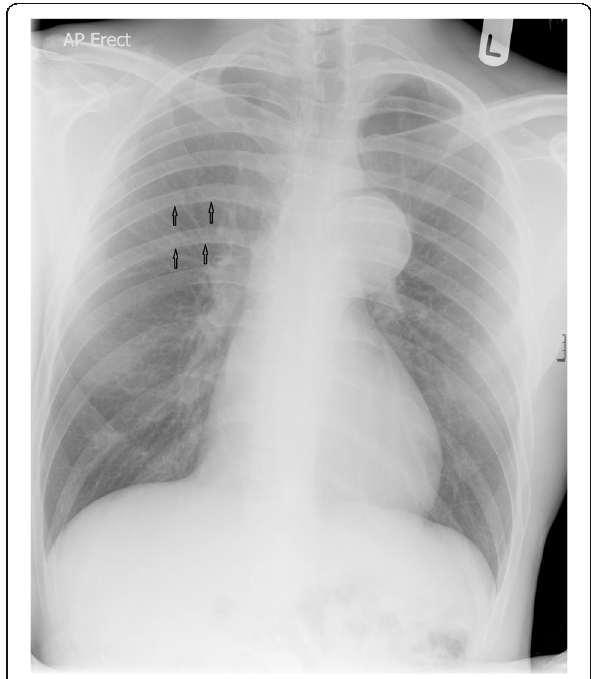
Fig. 1 Presenting chest radiograph with a large calcified aortic aneurysm and rib notching in the right upper zone (Black